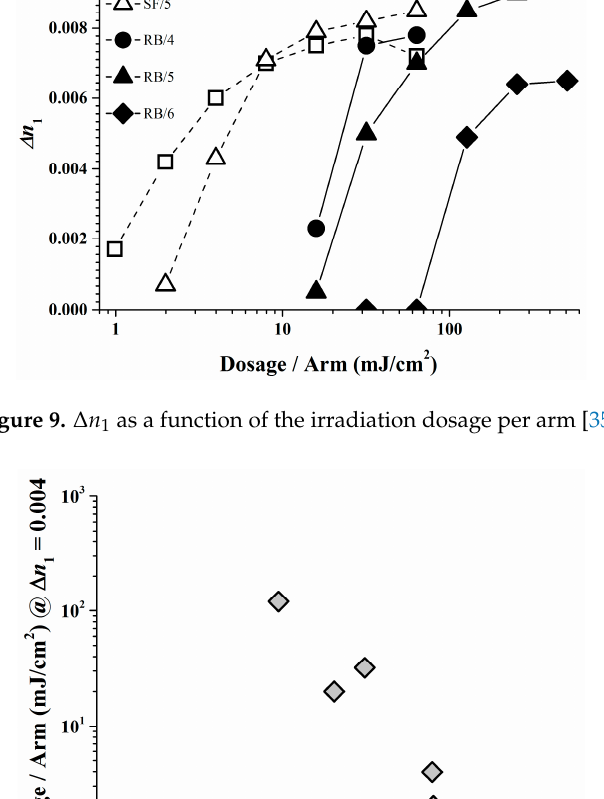
φ R 1 = 0.004 as a function of